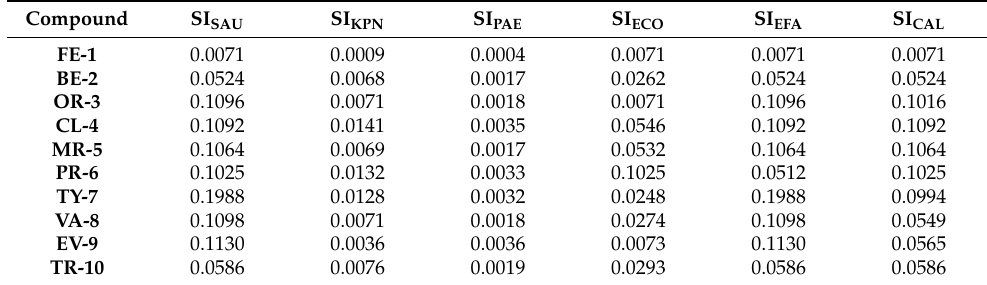
Table 7. Selectivity